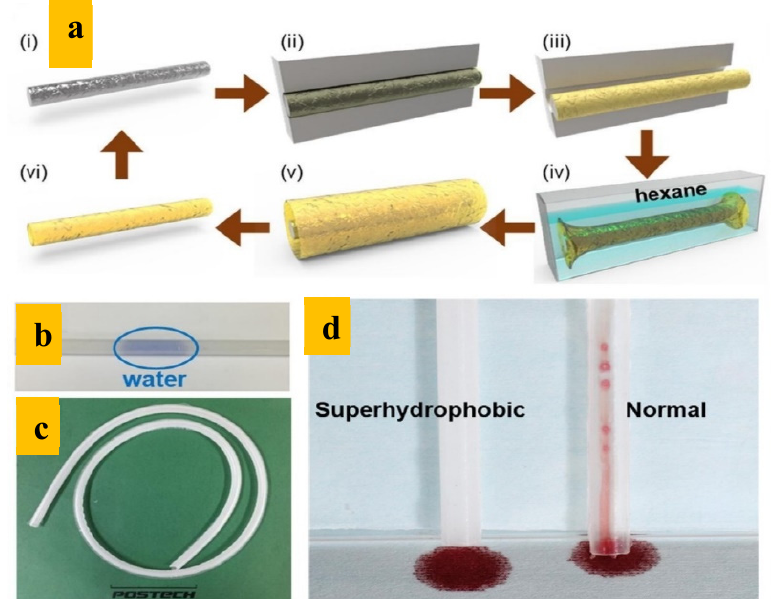
Figure 2. Fabrication process of the superhydrophobic PDMS tube reported by Kim et al. [36] ( a ) Schematic diagram of the replication and detachment process of the superhydrophobic tube, ( b ) optical image of the fabricated tube, ( c ) photograph of the tube showing its flexibility, ( d ) superhy- drophobic tube and the normal tube after blood was transferred through the tubes.